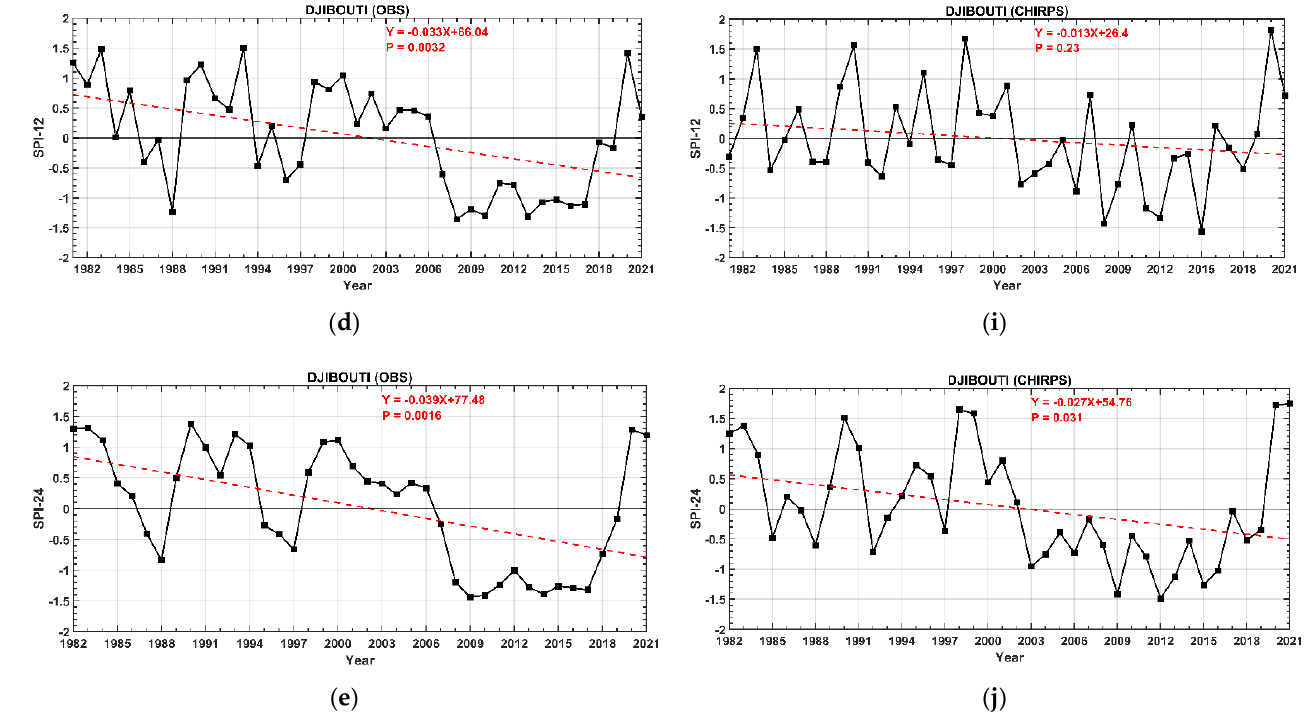
Figure 9. Interannual variations (black line) and linear trends (red line) of the annual mean of the SPI (3, 6, 9, 12, and 24 months) at Djibouti Airport station (left panels ( a – e ): observed data; right panels ( f – j ): CHIRPS data at the co-located grid point) during 1981–2021. Table 4. Linear trend values of the SPI and SPEI (3, 6, 9, 12, and 24 months) at Djibouti Airport station (observed and CHIRPS data) and in the two subregions over the 1981–2021 period.